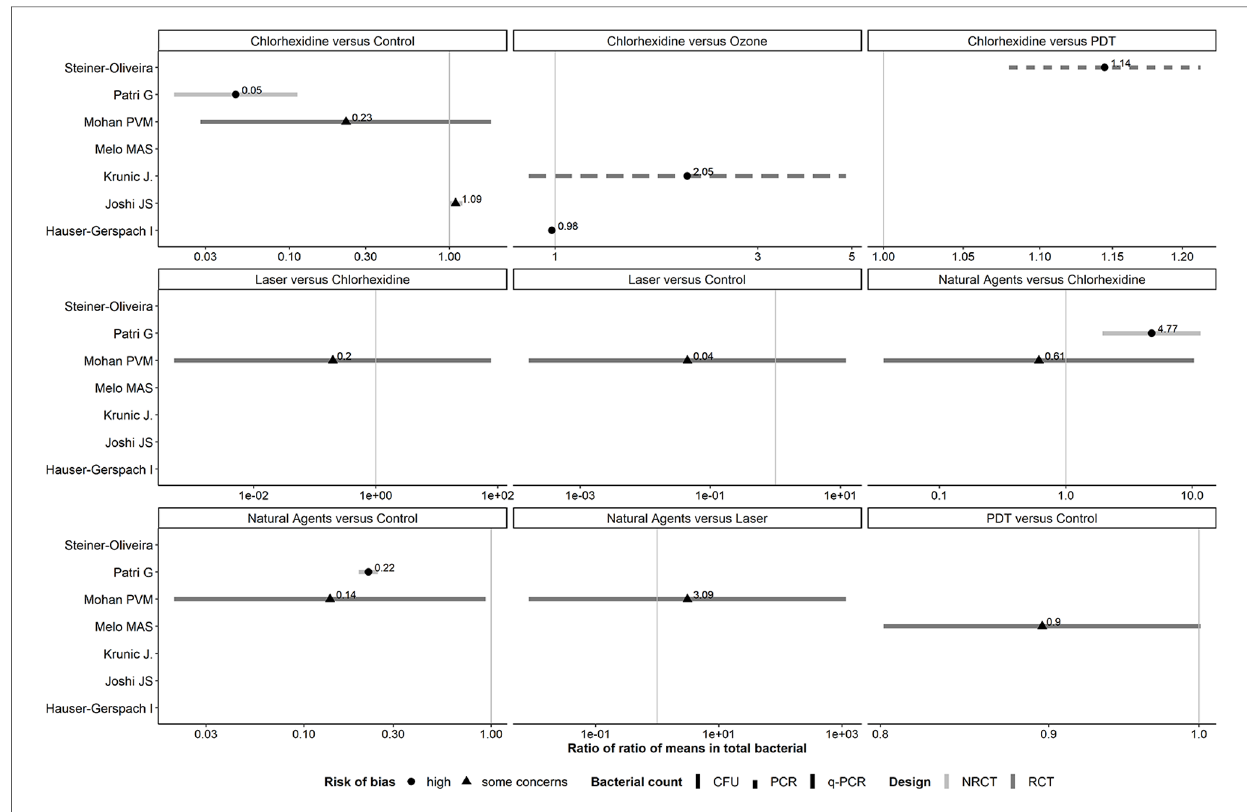
FIGURE 3 Forest plots showing roRoMs for total bacterial across the antiseptics